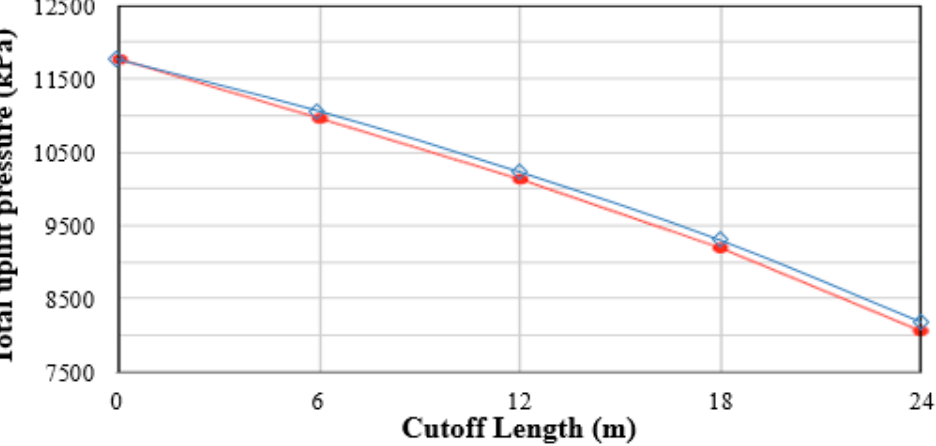
Figure 5. Total uplift pressure in different cutoff lengths for validation model.